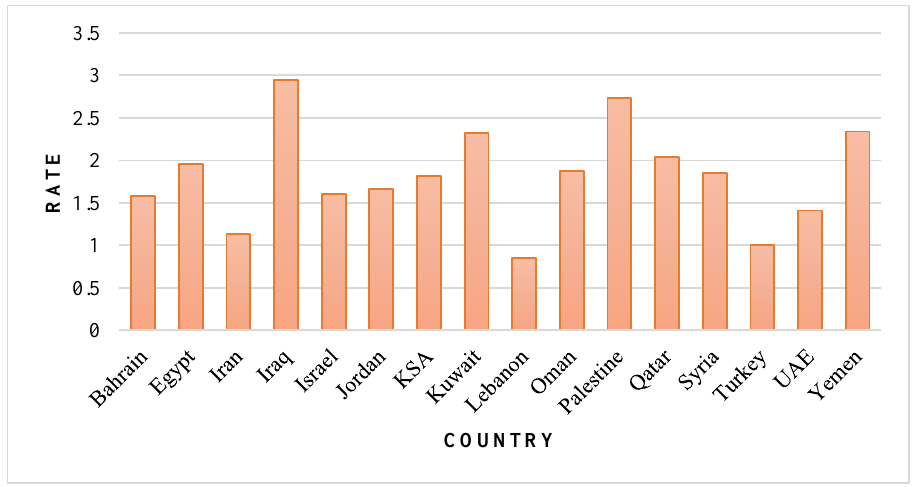
Figure 10. Annual population growth rate of the Middle Eastern countries in 2017. The data is acquired from: http://www.worldometers.info.